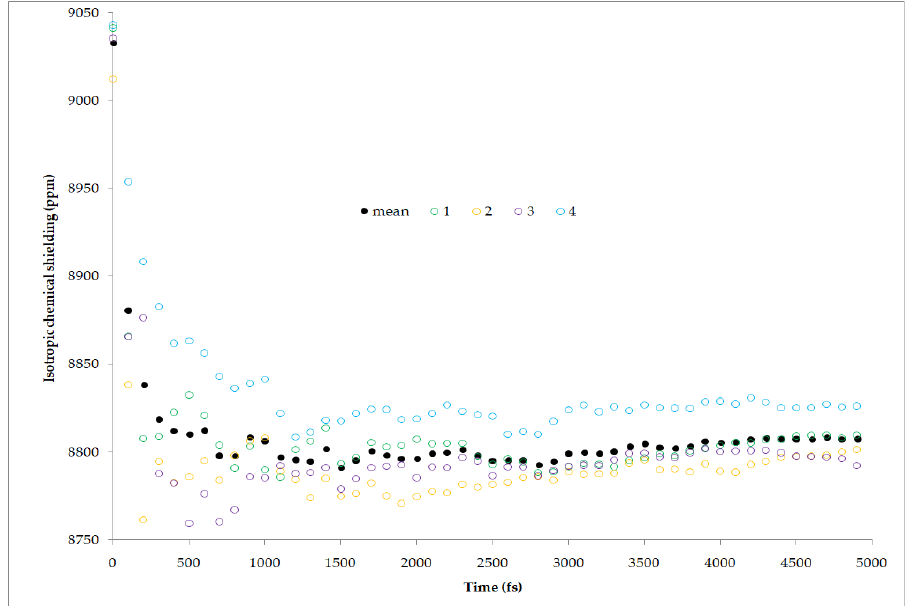
Figure 3. The convergence of the isotropic shielding for the Pb atom in Pb(NO 3 ) 2 with respect to the simulation time. The calculations were performed at 295 K, and the shielding values for the four equivalent atoms in the unit cell (1–4, color circles) were averaged (mean, black disk). Source: author’s personal archive.